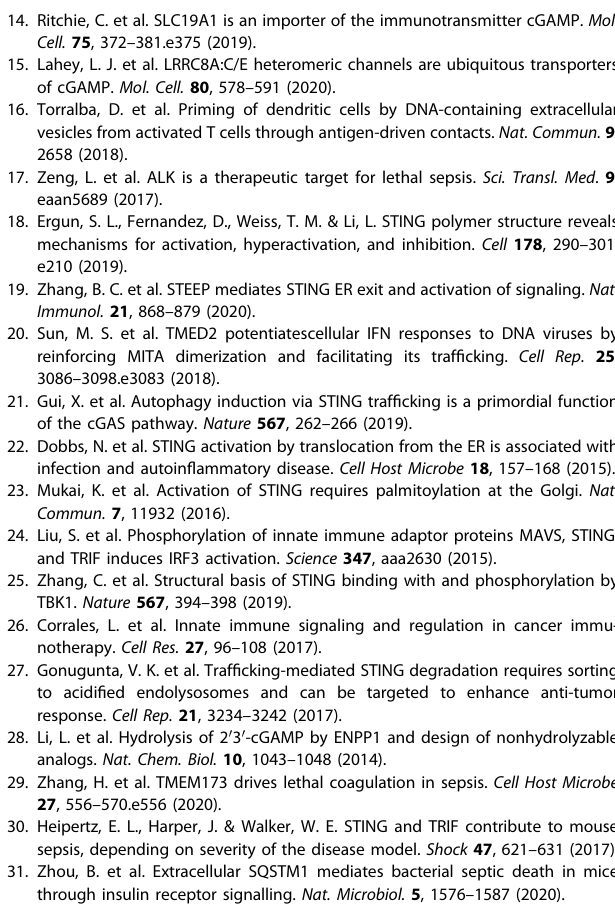
Fig. 6 The network of STING1 in in fl ammation, immune response, autophagy, and cell death. STING1 can be activated by bacteria-produced CDNs or CGAS-produced cGAMP. The activation of STING1 not only promotes in fl ammation and immune responses through TBK1-mediated activation of transcription factor, but also contributes to autophagy and various cell death modalities, such as apoptosis, necroptosis, pyroptosis, ferroptosis, mitotic death, immunogenic cell death, and autophagy-dependent cell death. GPX4 glutathione peroxidase 4, CDNs cytosolic cyclic dinucleotides, cGAMP cyclic GMP-AMP, ATG autophagy-related, STING1 stimulator of interferon response cGAMP interactor 1, ER endoplasmic reticulum, IRF3 interferon regulatory factor 3, NLRP3 NLR family pyrin domain containing 3, TBK1 TANK binding kinase 1, CASP caspase, NFKB1 nuclear factor kappa B subunit 1, MLKL mixed-lineage kinase domain-like